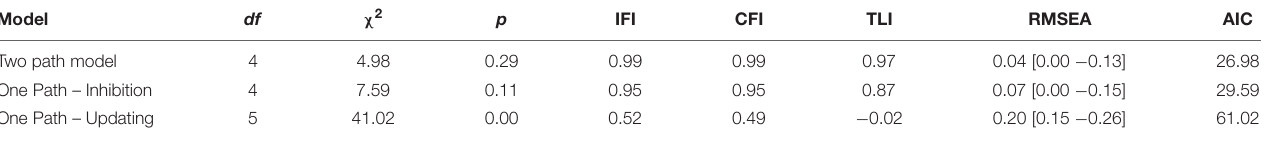
TABLE 2 | Fit indices for structural models of executive functions and critical thinking.